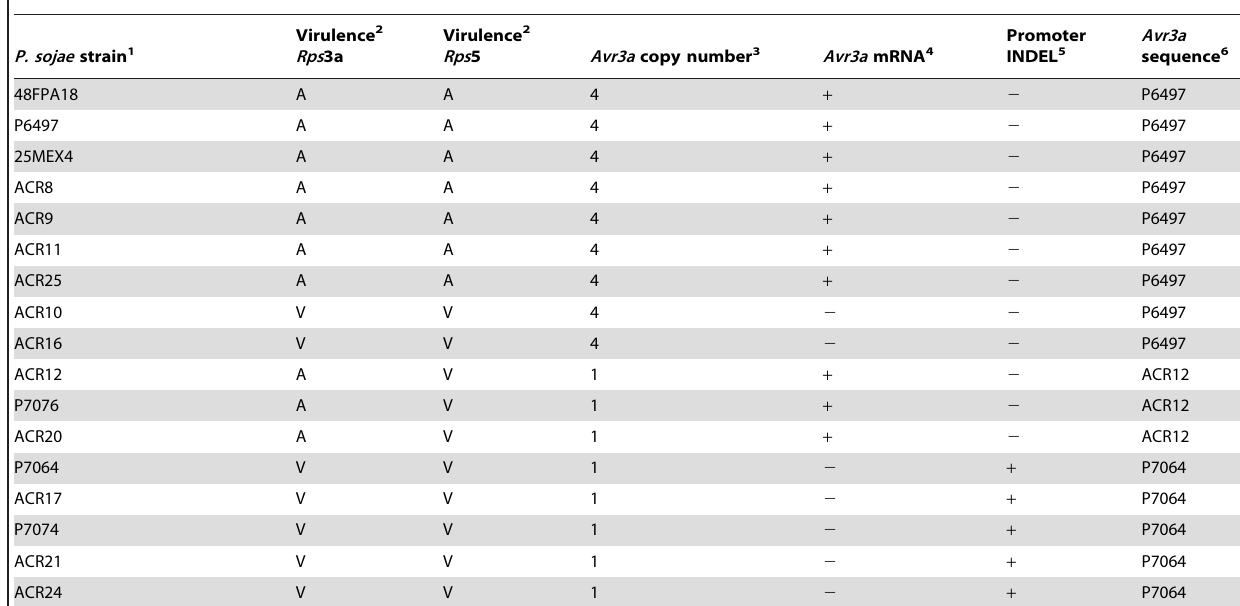
Table 2. Virulence phenotypes and haplotype analysis of P. sojae strains.